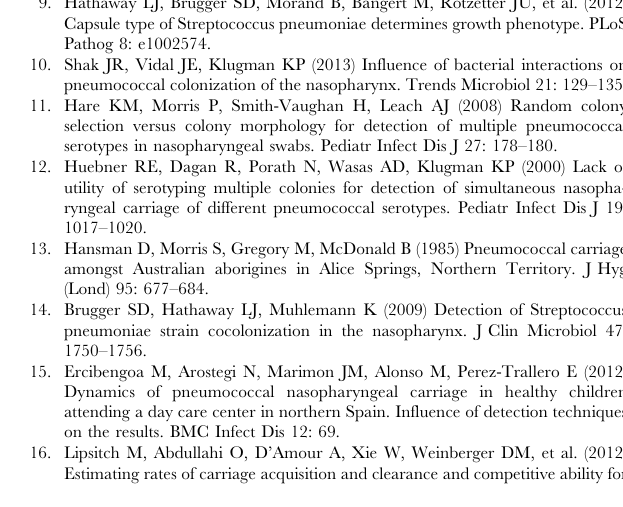
Table S1 Database of ARI and healthy children. Table S2 Data dictionary file of database of ARI and healthy